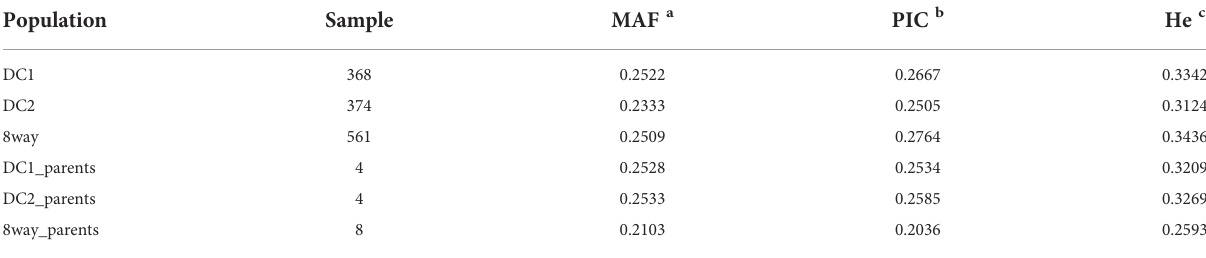
TABLE 1 Genetic diversity statistics of the DC1, DC2, 8way and their parental line populations.